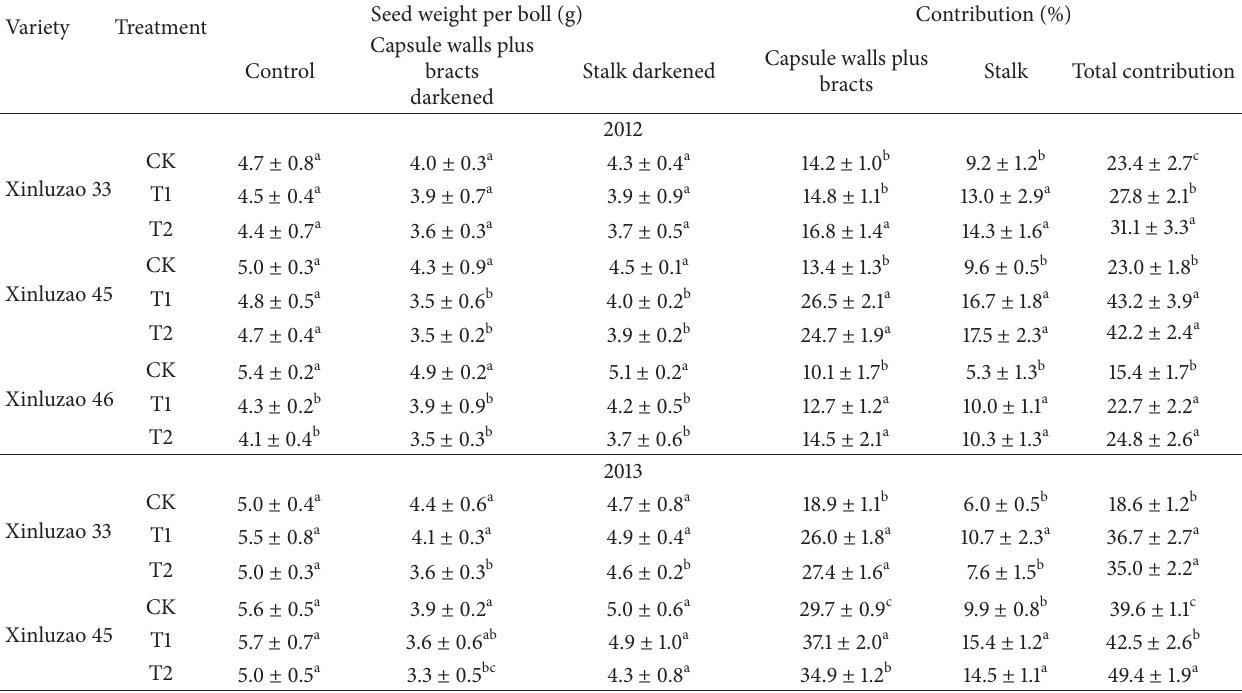
Table 4: Contribution of nonleaf organs to seed weight in cotton grown under different irrigation treatment in 2012 and 2013. Seed weight per boll (g) Contribution (%) Variety Treatment Capsule walls plus Capsule walls plus Control bracts Stalk darkened darkened